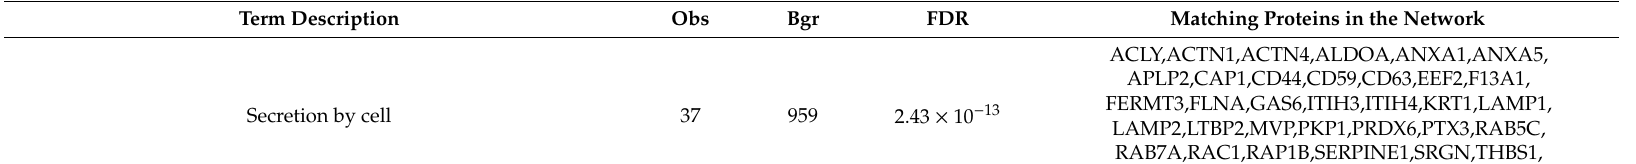
Gene Ontology (GO) Terms for Biological Processes10 Most Significant Results per FDR (for All GO Terms, See Supplementary Table